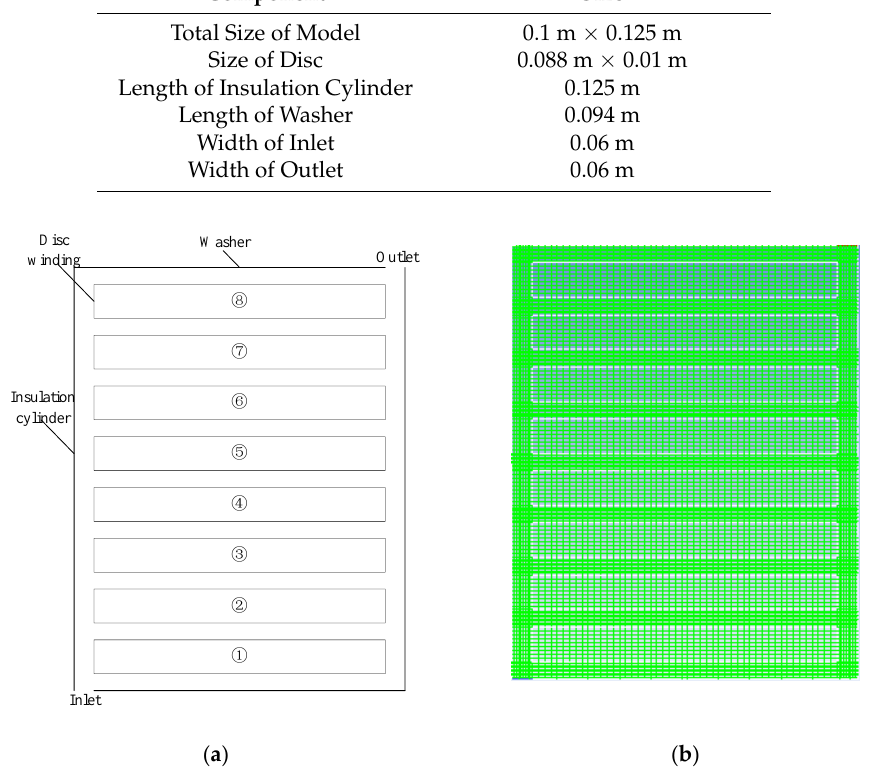
Figure 2. ( a ) Geometric graph of local winding model; ( b ) local winding model after meshing.